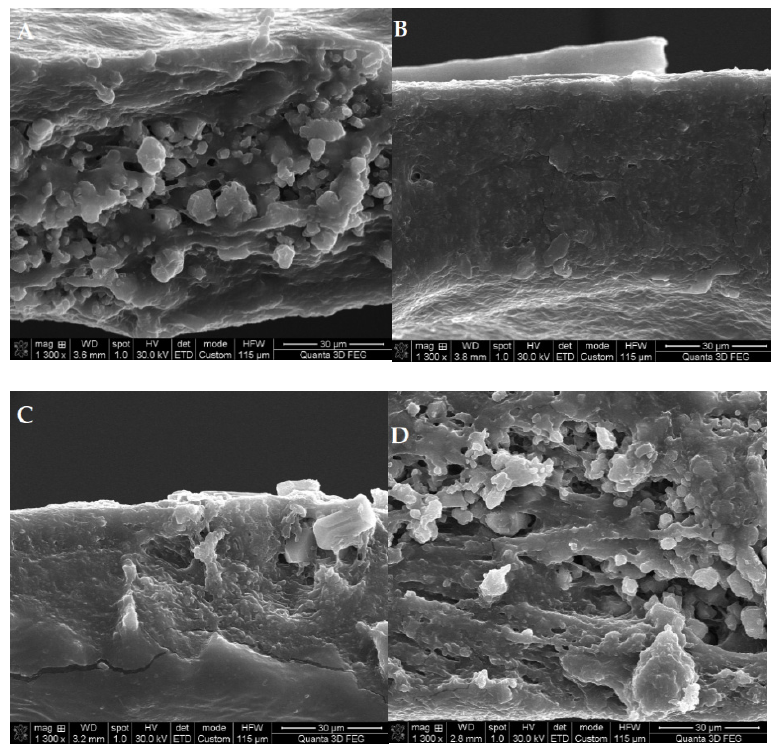
Figure 2. Cross-section of kefiran films plasticized with 7.5% glycerol, as a function of the type of film-forming solution (( A )—F_70.100; ( B )—F_80.30; ( C )—F_90.20; ( D )—F_100.5). Magnification is indicated in the micrographs.